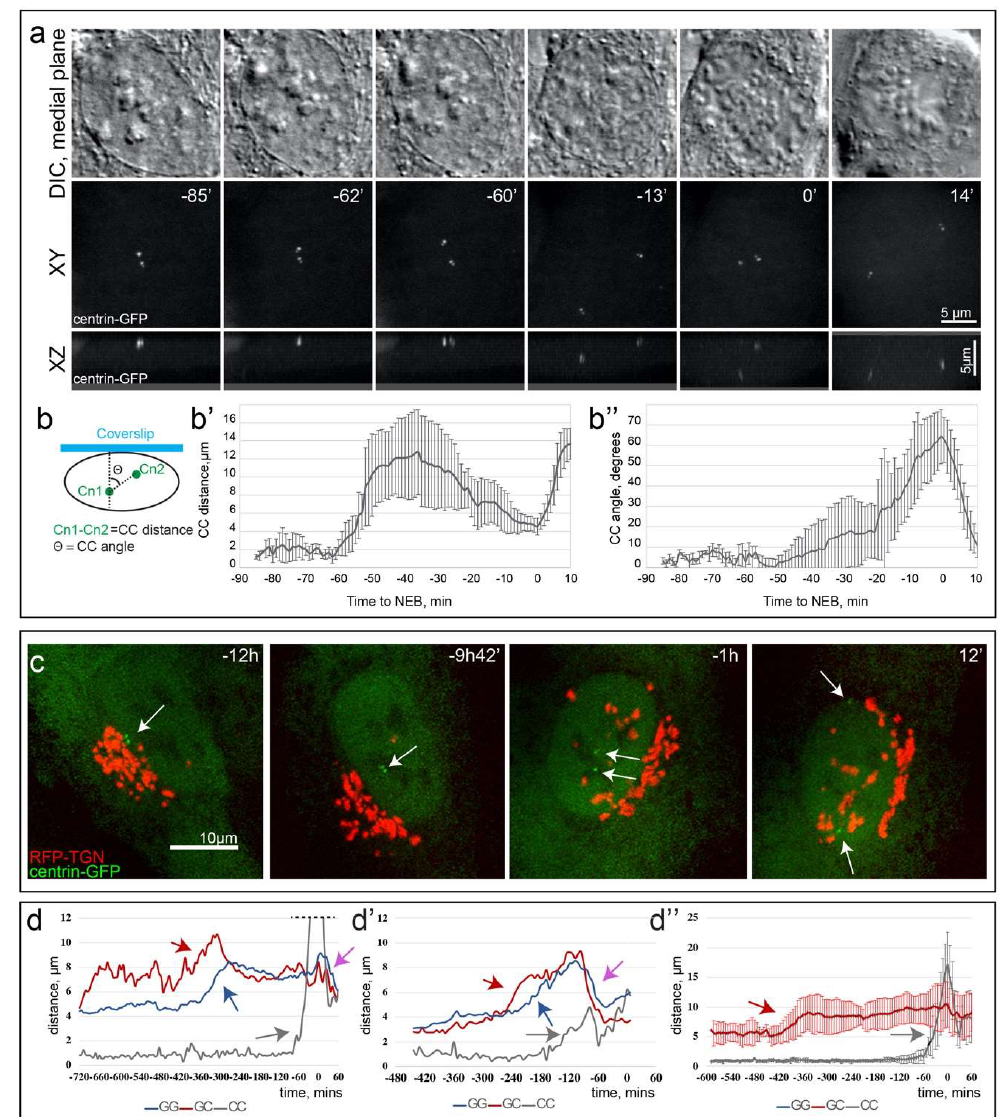
Figure 5. Centrosome separation occurs in E mode, after dissociation from the Golgi. ( a ) Frames from multi-mode DIC (upper row) and wide-field epifluorescence 3D time-lapse recordings. GFP-centrin is shown as maximum intensity projections (middle row, XY view; lower row, XZ view). Arrows indicate centrosomes. Scale 5 µm. Time point “0” indicates NEB. Time, minutes. ( b – b” ) Quantification of centrosome positioning in data like in ( a ). ( b ) Schematic of centrosome-centrosome (CC) distance and angle quantification. ( b’ ) Dynamics of CC distance over time. ( b’’ ) Dynamics of CC angle over time. n = 13. Error bars, SD. ( c ) Frames from a time-lapse imaging sequence of RPE1 cells stably expressing Golgi (RFP-TGN, red) and centrosome markers (centrin1-GFP, green) during E mode progression. White arrows indicate centrosome position. Scale 10 µm. Time points correspond to values approaching “0” which indicates the maximal CC. Time, hours, minutes. Maximum intensity projection of entire spinning disk confocal stacks. ( d , d’ ) GG (blue line), GC (red line), and CC (grey line) distance profile for representative cells. Grey arrows indicate the CC distance increases after increase of GG (blue arrows) and GC (red arrows), but prior to GG/GC decreases (purple arrows) indicating C2 mode. Top of graph in 5d was cut to highlight changes in GG/GC/CC distances. Time point “0” indicates the maximal CC. Time, minutes. ( d” ) Averaged GC (red) and CC (gray) profiles over time. Sequences aligned by the maximum CC (time point “0”). Note that GC (red arrow) increases significantly earlier than CC (grey arrow). n = 11. Error bars, SD. Time,